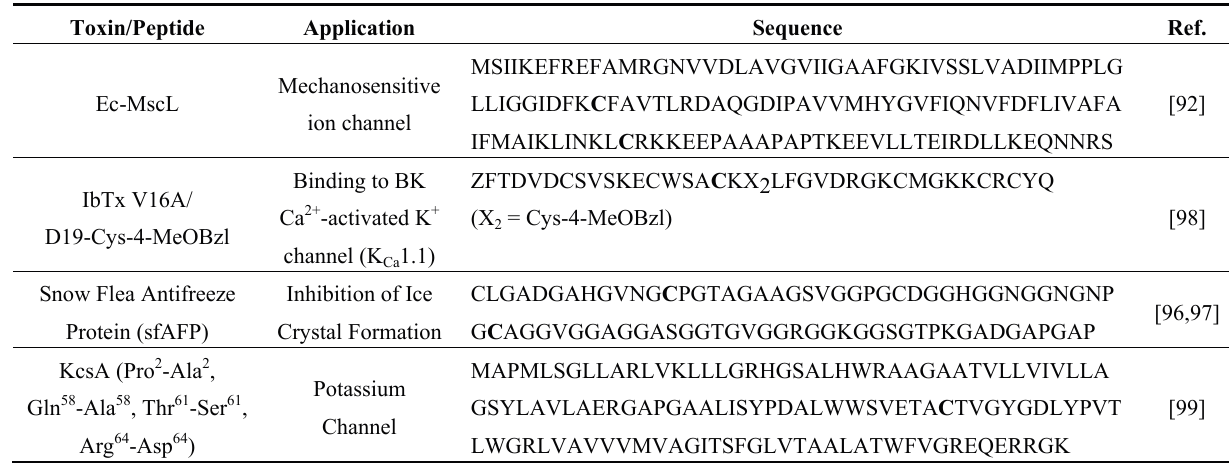
Table 3. Examples of the application of NCL to synthesize challenging peptide sequences. Cysteine residues used as ligation sites are in bold and larger